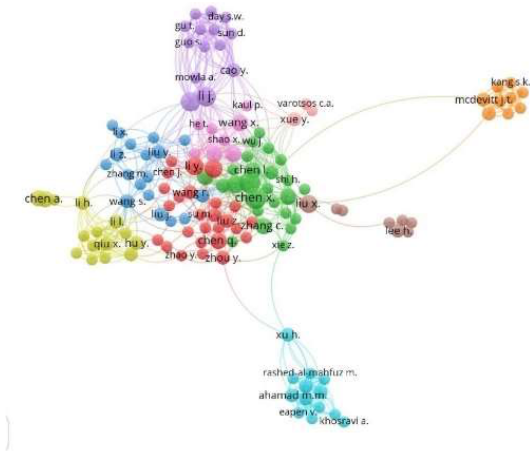
Figure 10. Citation and co-authors analysis.